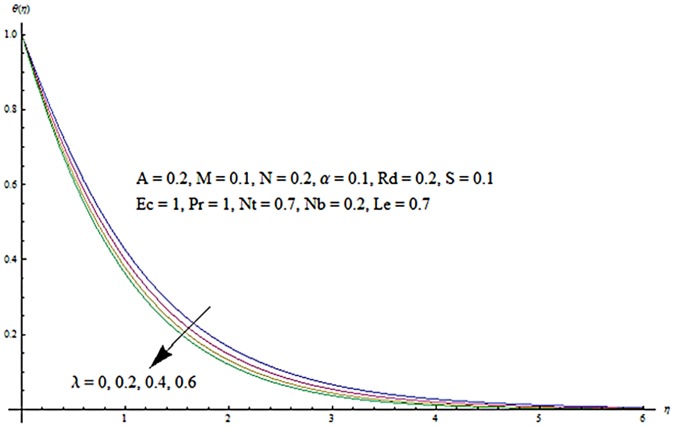
Influence of λ on θ.